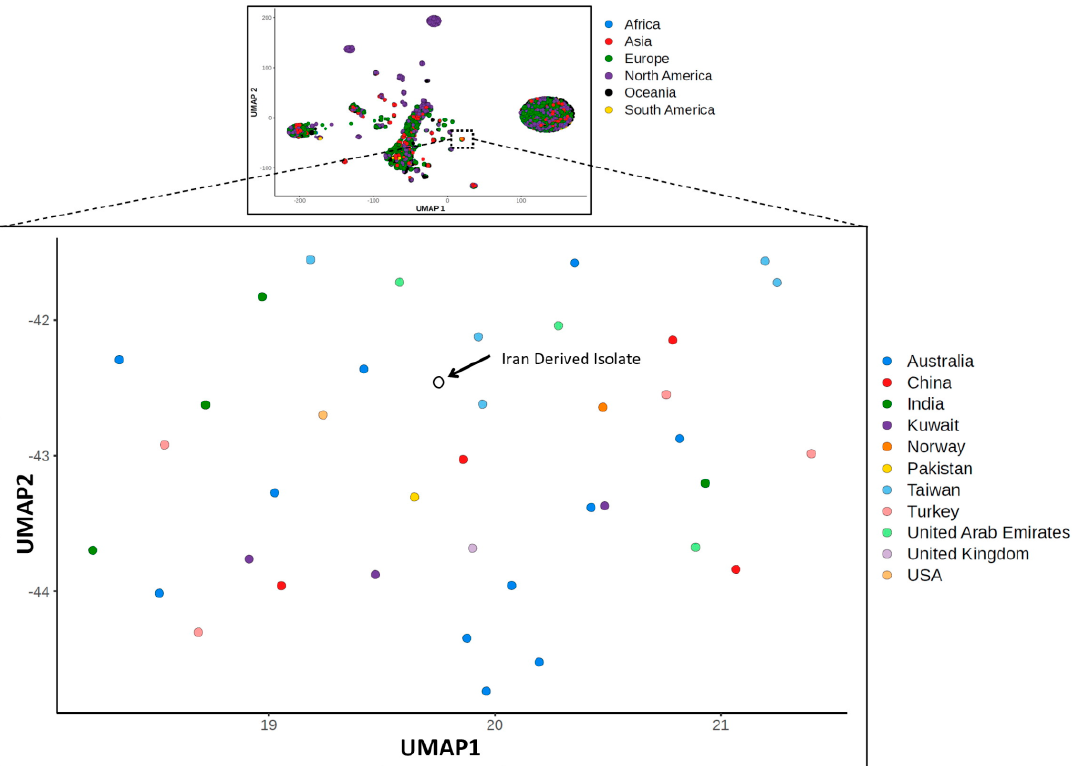
Figure 3. Uniform manifold approximation and projection (UMAP) involving the aligned genomes of 8075 SARS-CoV-2 isolates labelled by country of origin. The Iran-derived sample is indicated by an arrow. The top inset illustrates the analysis of all 8075 isolates, labelled by region, with the zoomed region indicated by the hashed